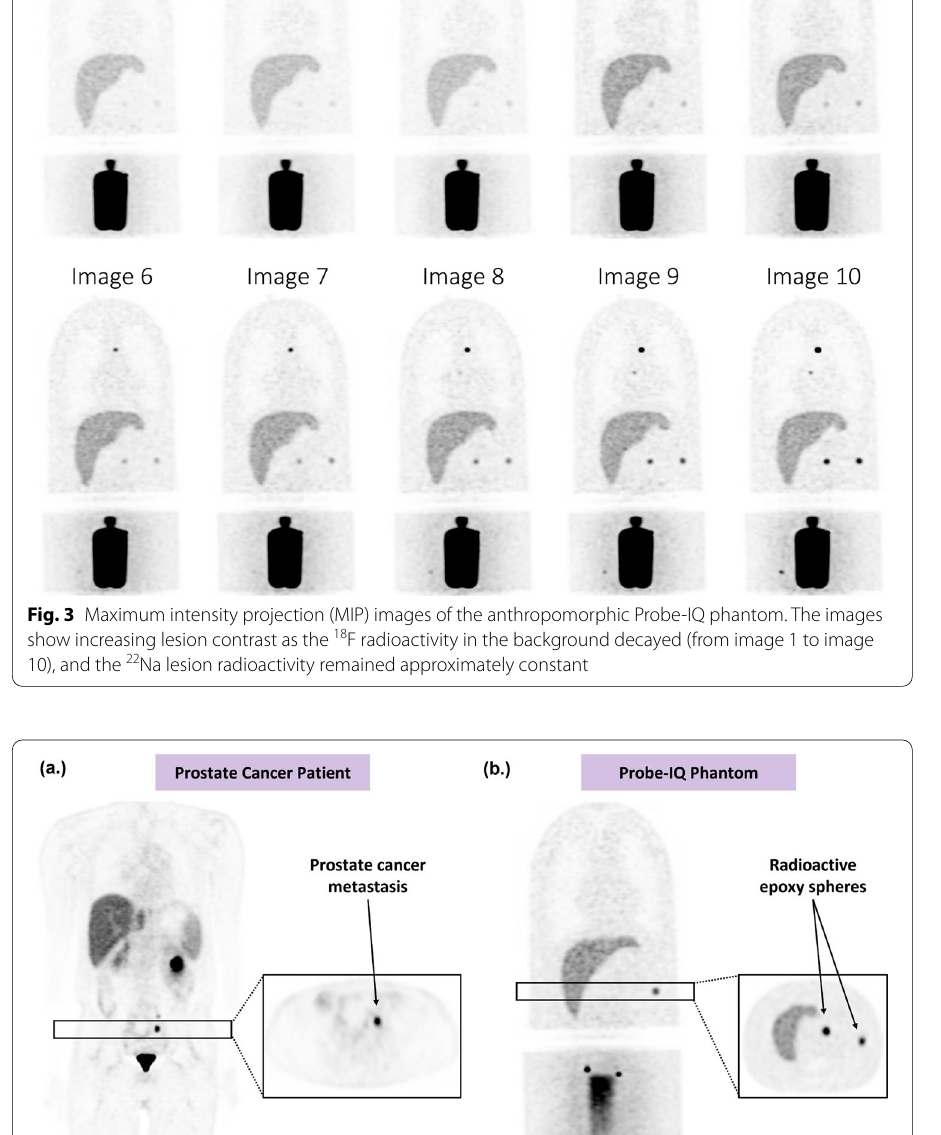
Electric (GE). The BSREM image reconstruction algorithm utilizes a Relative Difference Penalty (RDP), R ( x ) , which is inserted into the cost function: